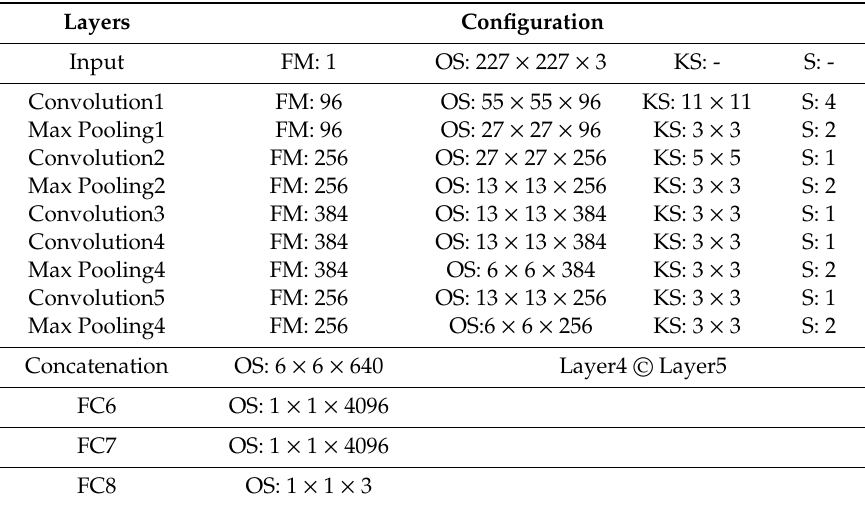
Figure 13. The improved CNN network structure. Table 2. The parametric detail of improved